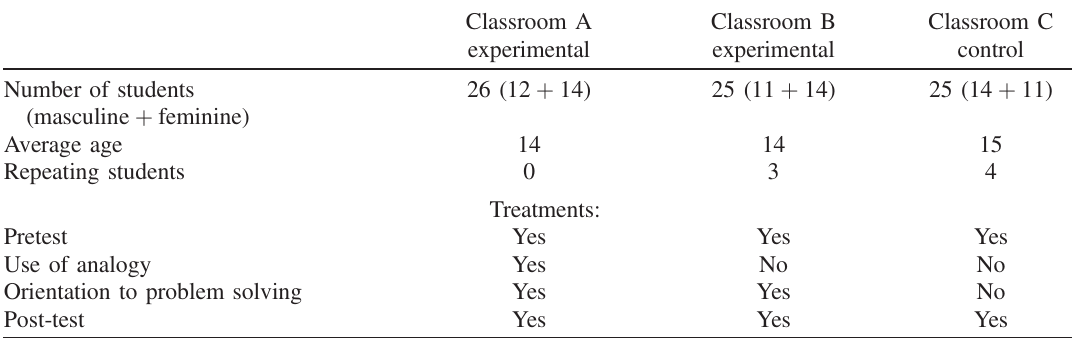
TABLE I. The three classroom samples and their different treatments.